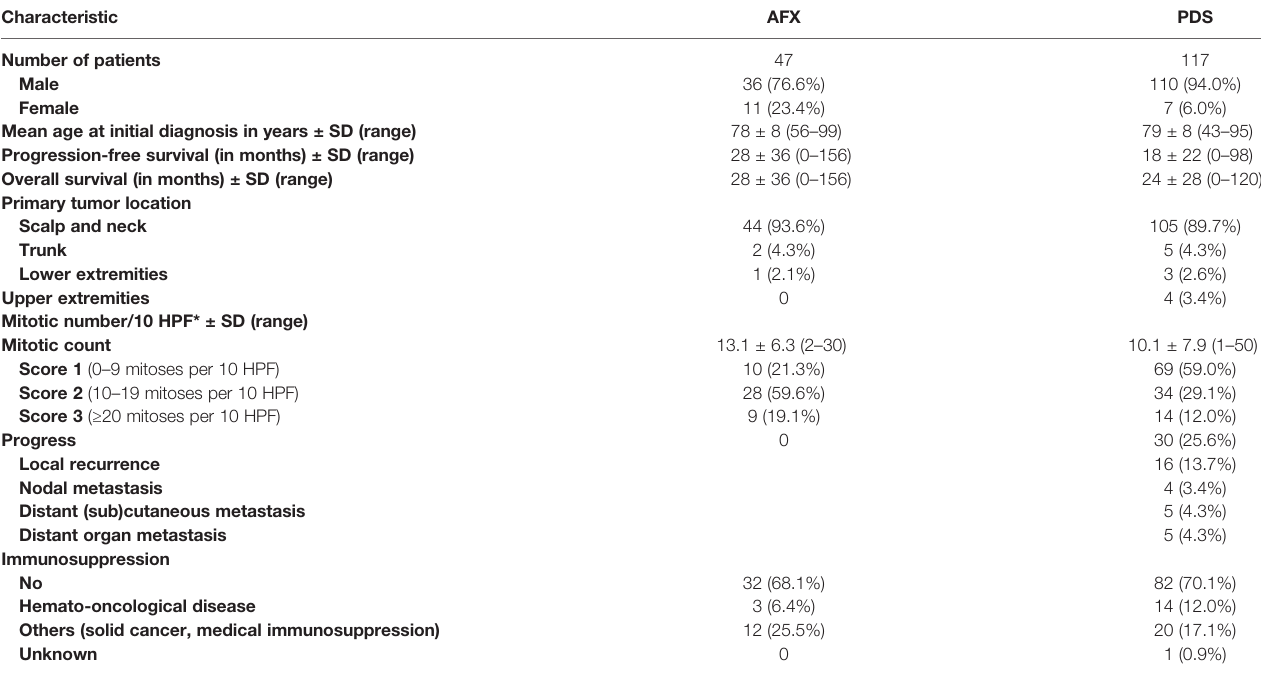
TABLE 1 | Clinical characteristics of AFX/PDS